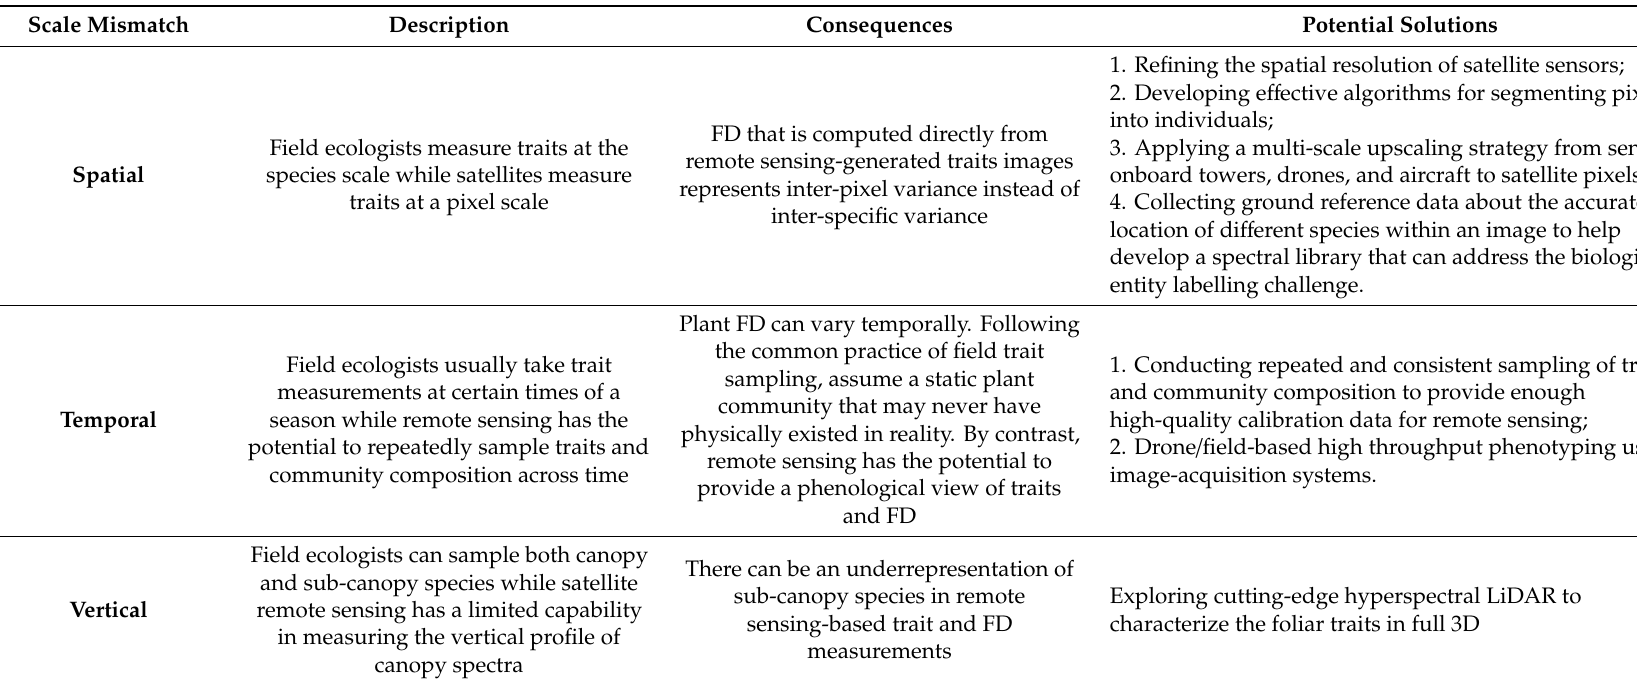
Table 2. The three scale mismatches and the potential technical innovations that can bridge